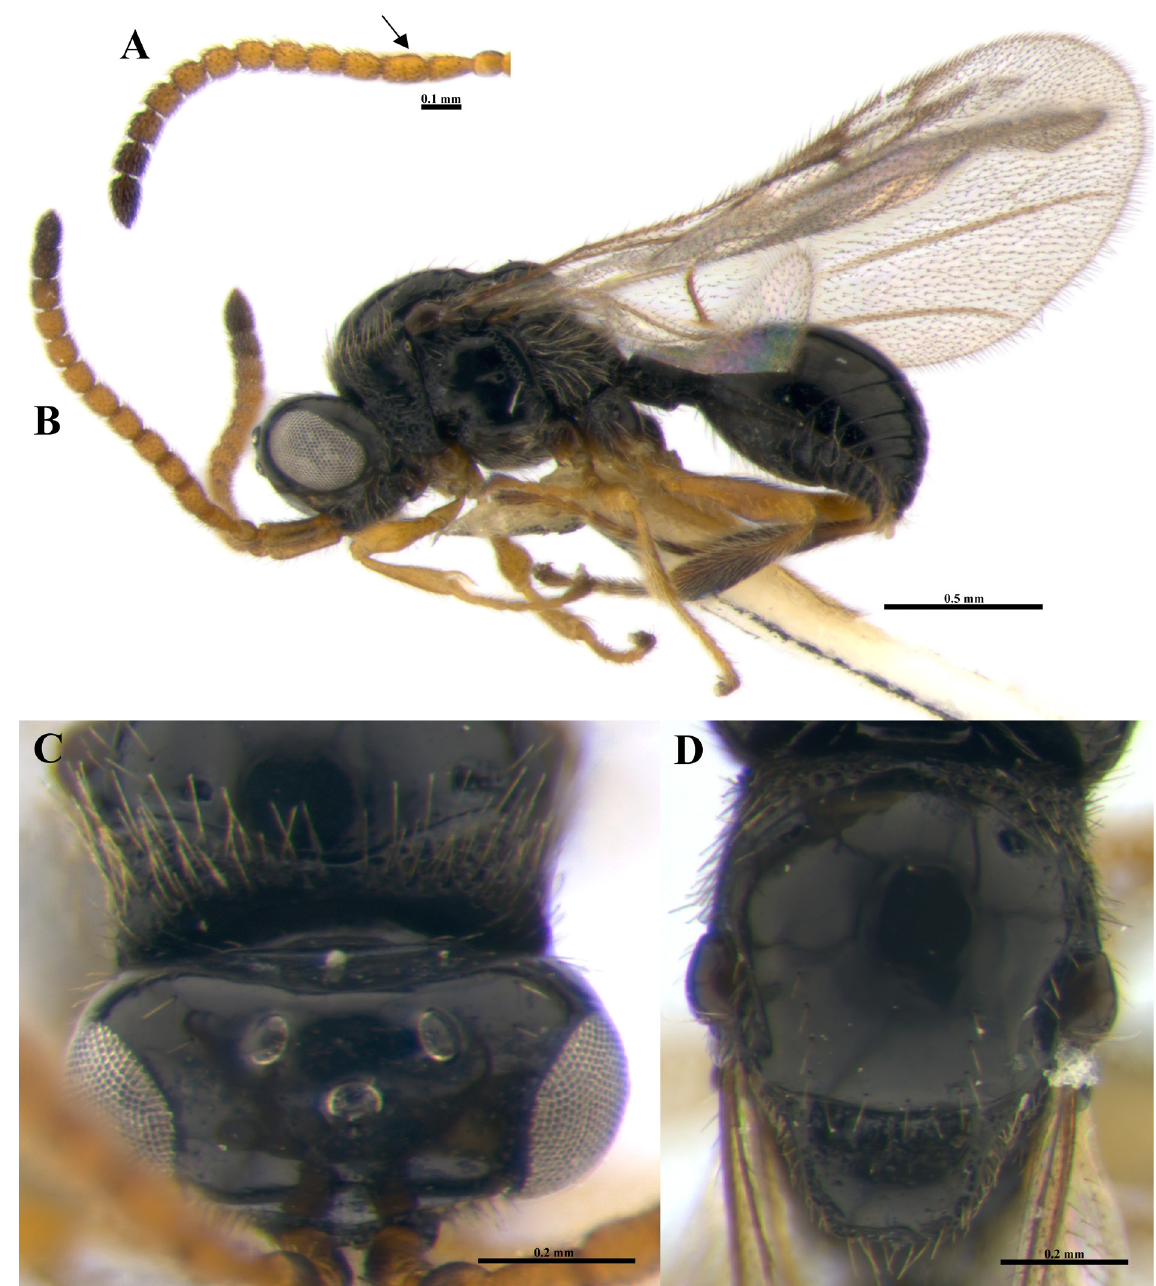
Fig. 3. Ismarus brevis Kim & Lee sp. nov., holotype, ♂. A . Antenna. B . Habitus in lateral view. C . Head in dorsal view. D . Mesosoma in dorsal